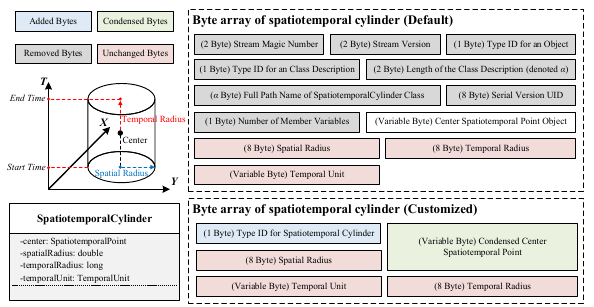
Figure 6. Representations of default and customized serializations for spatiotemporal cylinder